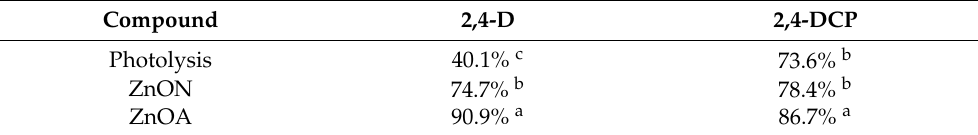
Figure 8. Degradation activities: 2,4-D ( a ) and 2,4-DCP ( b ). Table 3. Percentage of degradation after 6 h f reaction. Table 3. Percentage of degradation after 6 h f reaction.